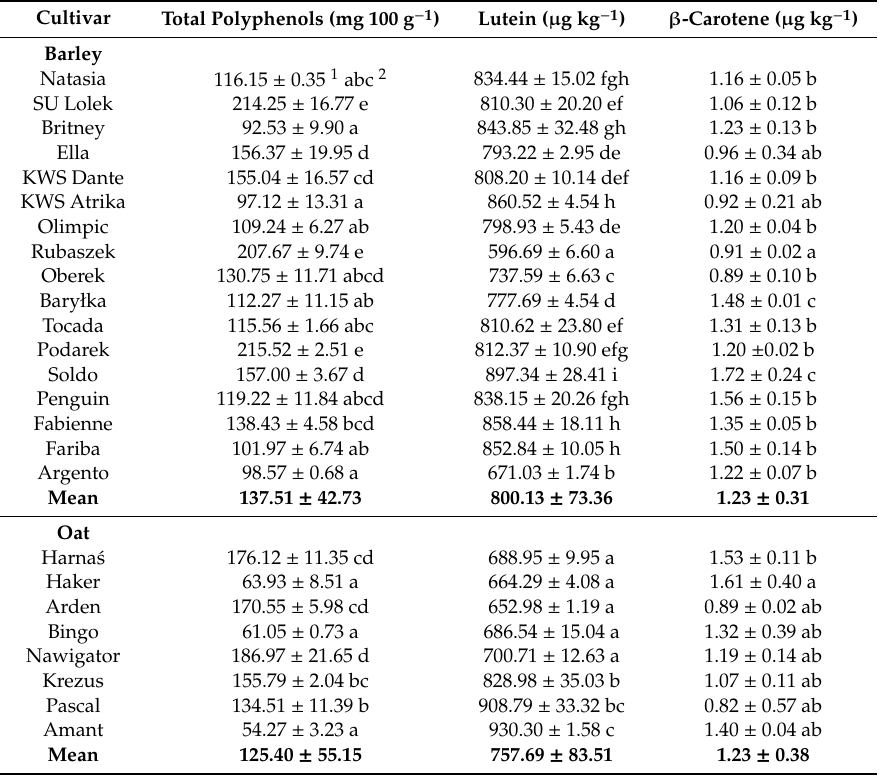
Table 6. Total polyphenols, lutein and β -carotene content in grains of barley and oat cultivars grown organically in the controlled field trial in